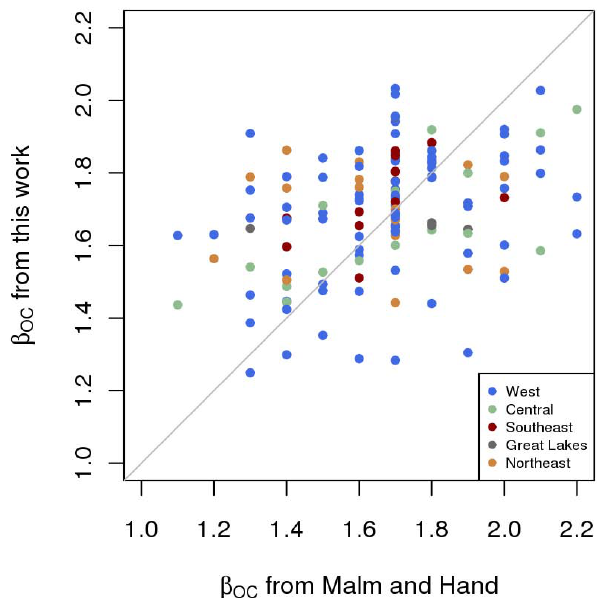
Fig. 13. Comparisons of β OC values reported by Malm and Hand (2007) to multiyear β OC values from this